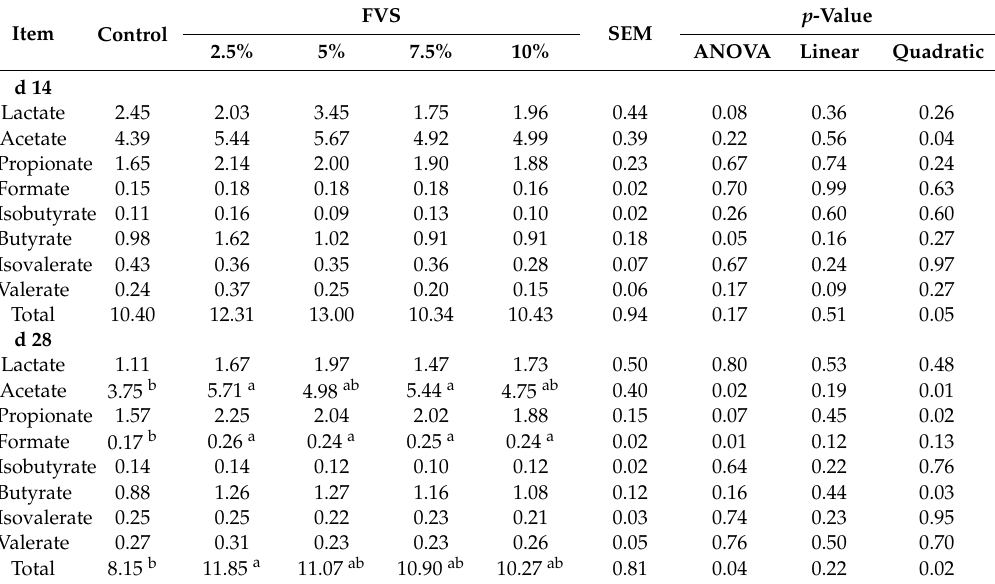
Table 5. E ff ects of dietary Flammulina velutipes stem waste (FVS) supplementation on short chain fatty acids (SCFAs) production measured in fresh feces of weaned piglets on day 14 and day 28 (mg / g)